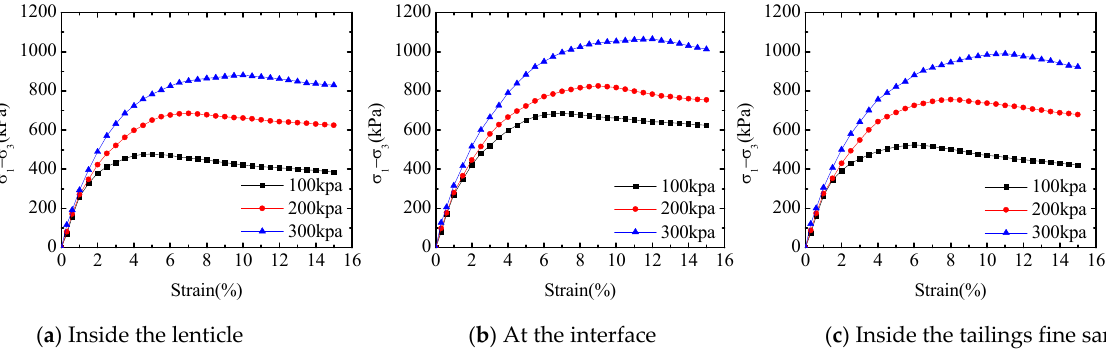
Figure 7. Deviatoric stress-strain curves of reinforced soil under different confining pressure, n = 2. ( a ) Inside the lenticle, ( b ) At the interface, ( c ) Inside the tailings fine sand.